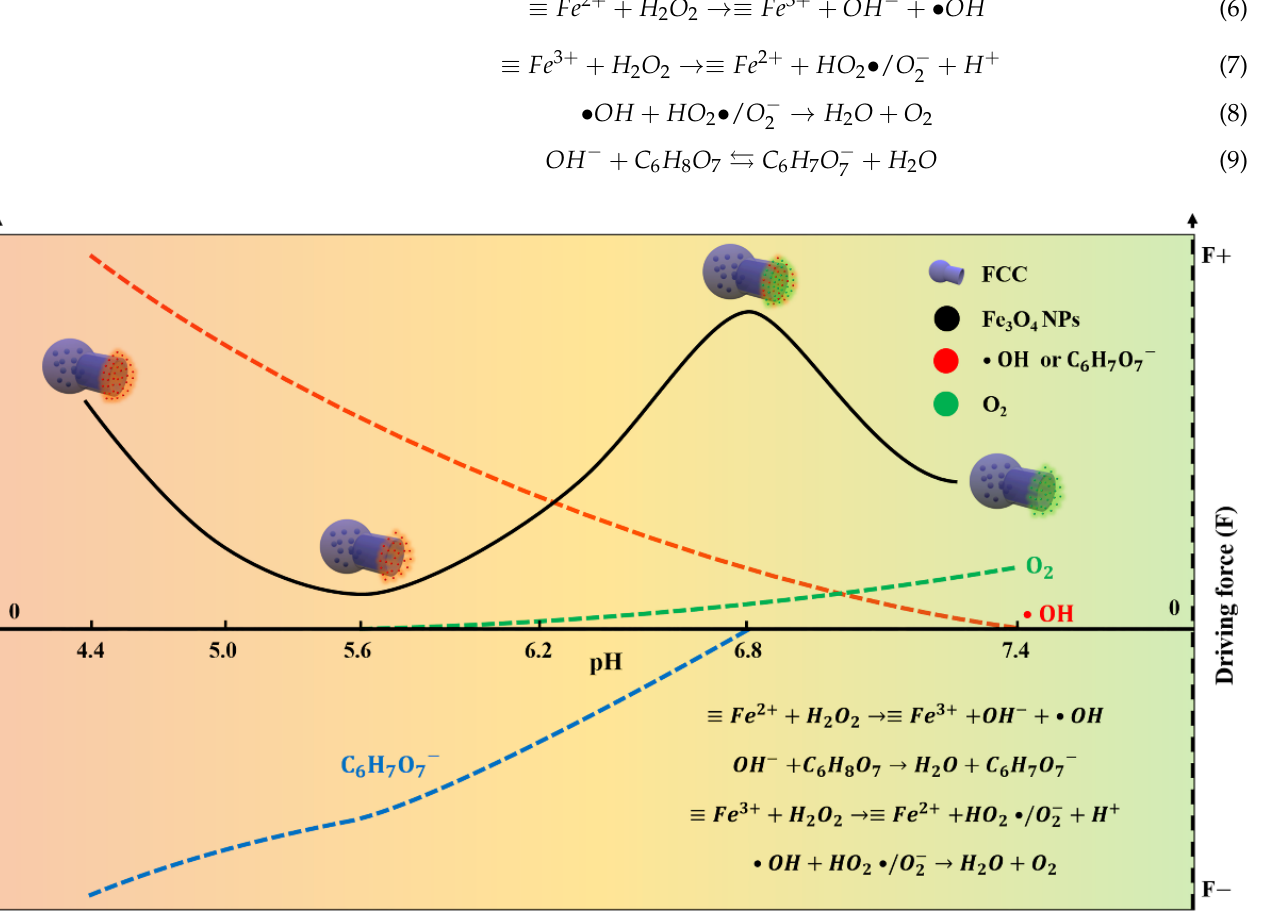
Figure 1. Schematic of the self-adaptive pH-responsive motion behaviors of the as-prepared FCNMs based on the pH-dependent catalytic activities of Fe 3 O 4 NPs. The velocity and driving force toward the flask mouth direction were set to be positive (V+ and F+). At a lower pH value, the FCNMs were driven by the co-effect of C 6 H 7 O 7 - and • OH diffusiophoresis in the opposite directions. With the reduction of ionic diffusiophoresis and the addition of O 2 diffusiophoresis, the motion velocity increased in the weak acid environment. In the near alkaline range, O 2 diffusiophoresis provided the driving force for the FCNMs showing a reduction of the velocity.